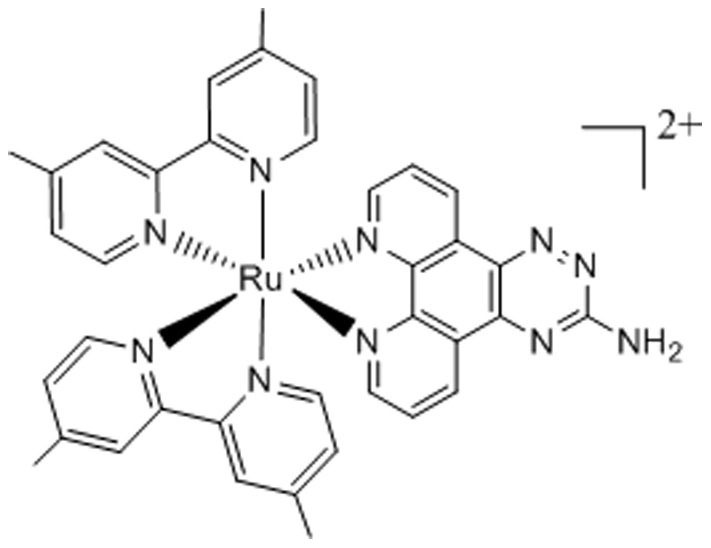
Structure of ruthenium(II) complex R-825 [10].